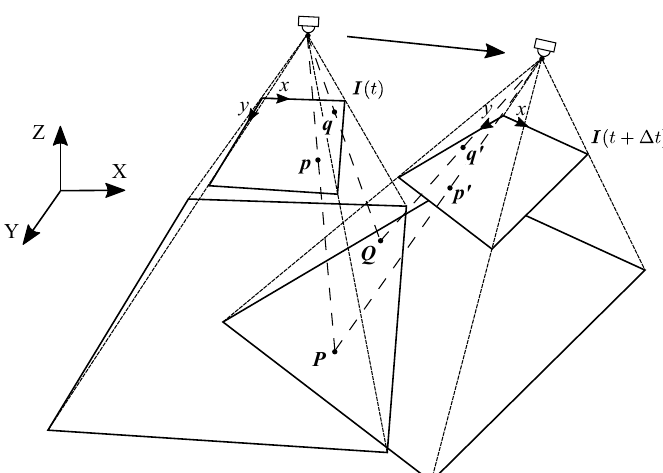
Figure 2. A pair of aerial images, I ( t ) and I ( t + ∆ t ) (the camera’s image planes). Point P is considered to be on the reference surface and point Q above it. The projections of these points on their respective image planes are shown as p and q on I ( t ) and p’ , and q’ on I ( t + ∆ t ) .